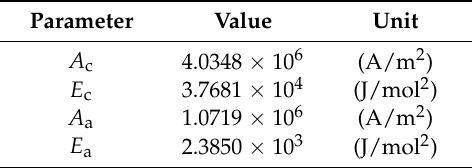
Table 4. Parameters for reference exchange current density.